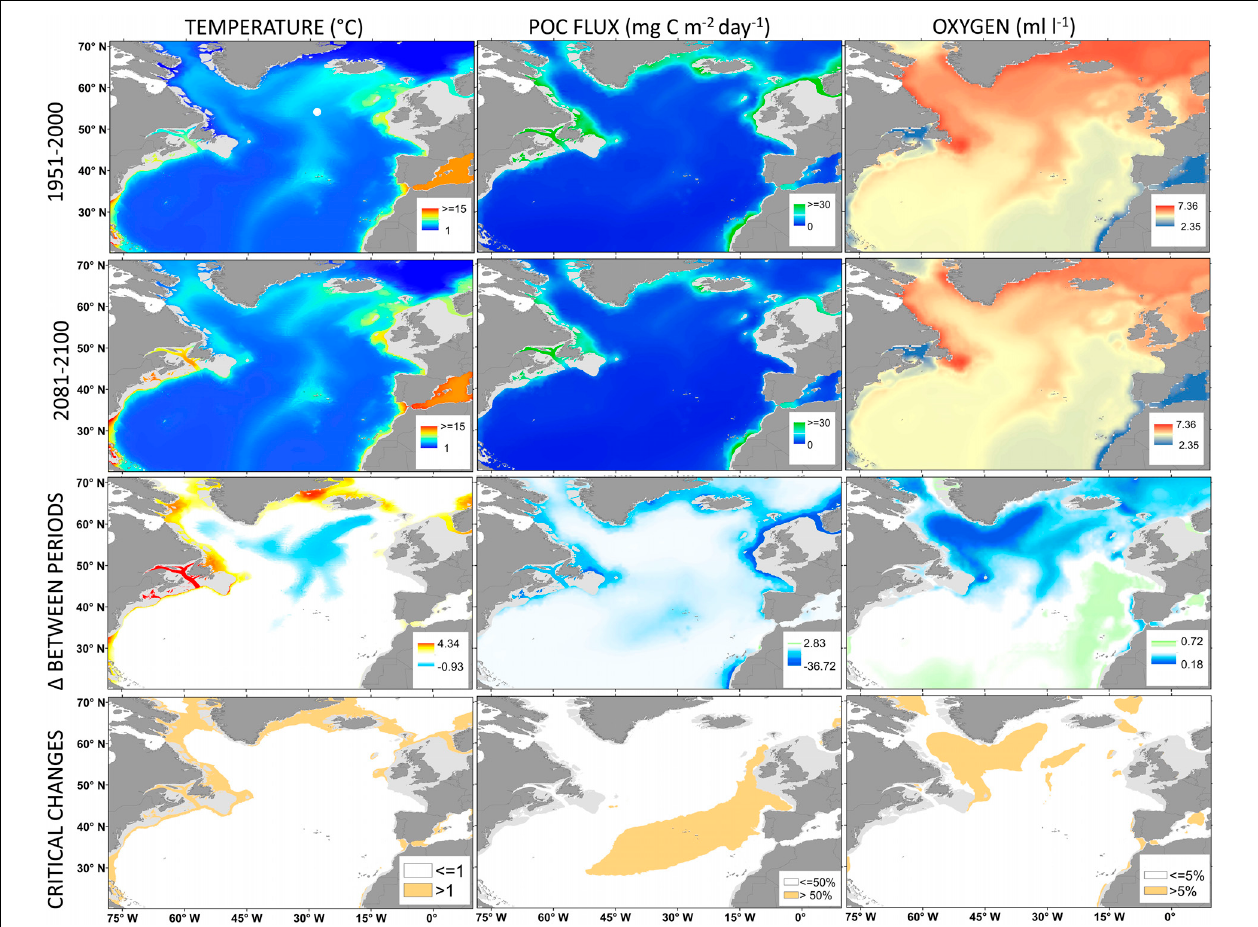
FIGURE 3 | Present and future scenarios predicted for temperature, particulate organic carbon (POC) flux and dissolved oxygen at the seafloor in the North Atlantic Ocean. Changes, as increment ( (cid:49) ) between periods, were measured as the difference between present-day and the modeled conditions by 2100. Areas with critical changes in the values of a given water mass property are